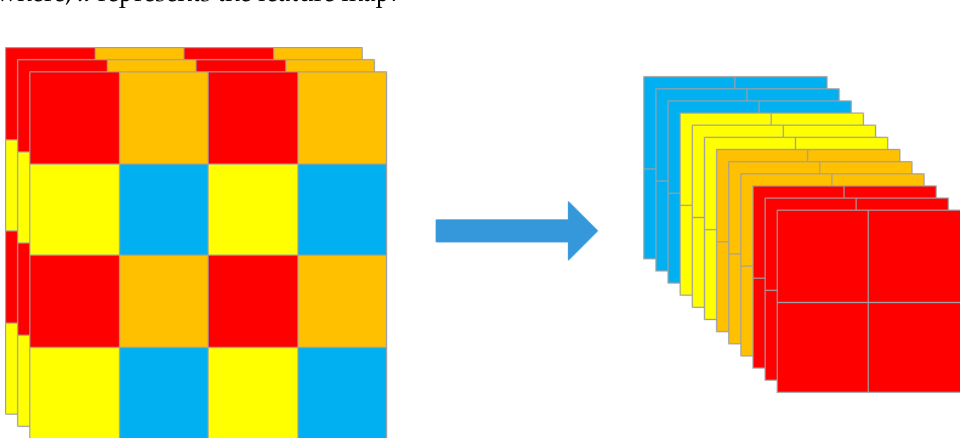
Figure 4. Foucs structrue.